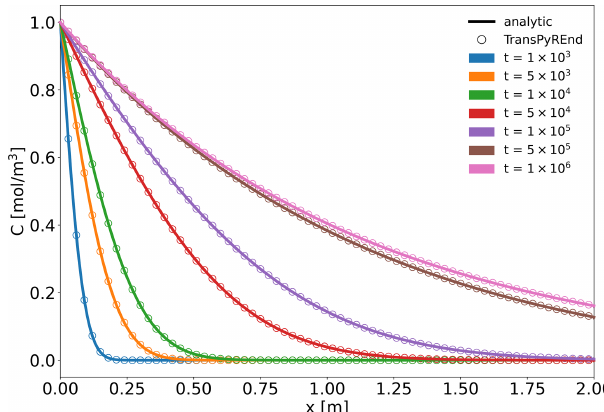
Figure 3. Comparison between the analytic solution by Van Genuchten (1981) (lines) and TransPyREnd (circles) for various times.